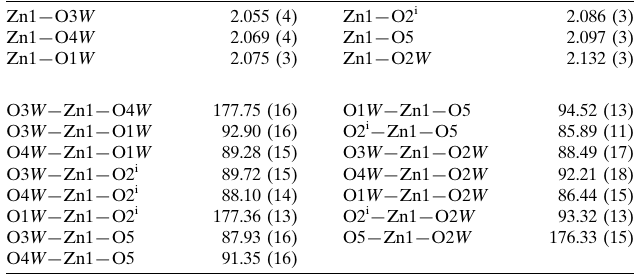
chain running along the [110] direction. The Zn II atom is hexa- coordinated in a distorted octahedral geometry by six O atoms and four water molecules. The crystal packing is stabilized by intermolecular